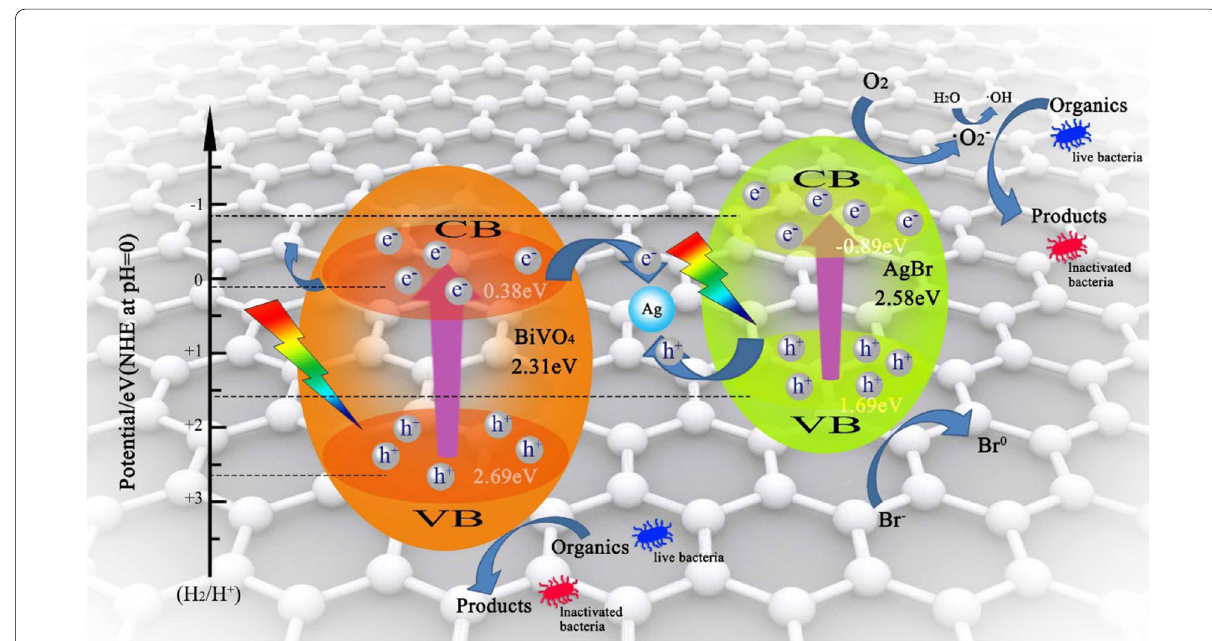
Fig. 12 The proposed tentative mechanism for photocatalytic disinfection of Ag-AgBr/ BiVO 4 /GA composite under visible light irradiation. Adapted from Ref. [131] with permission. Copyright (2020) Colloids and Surfaces